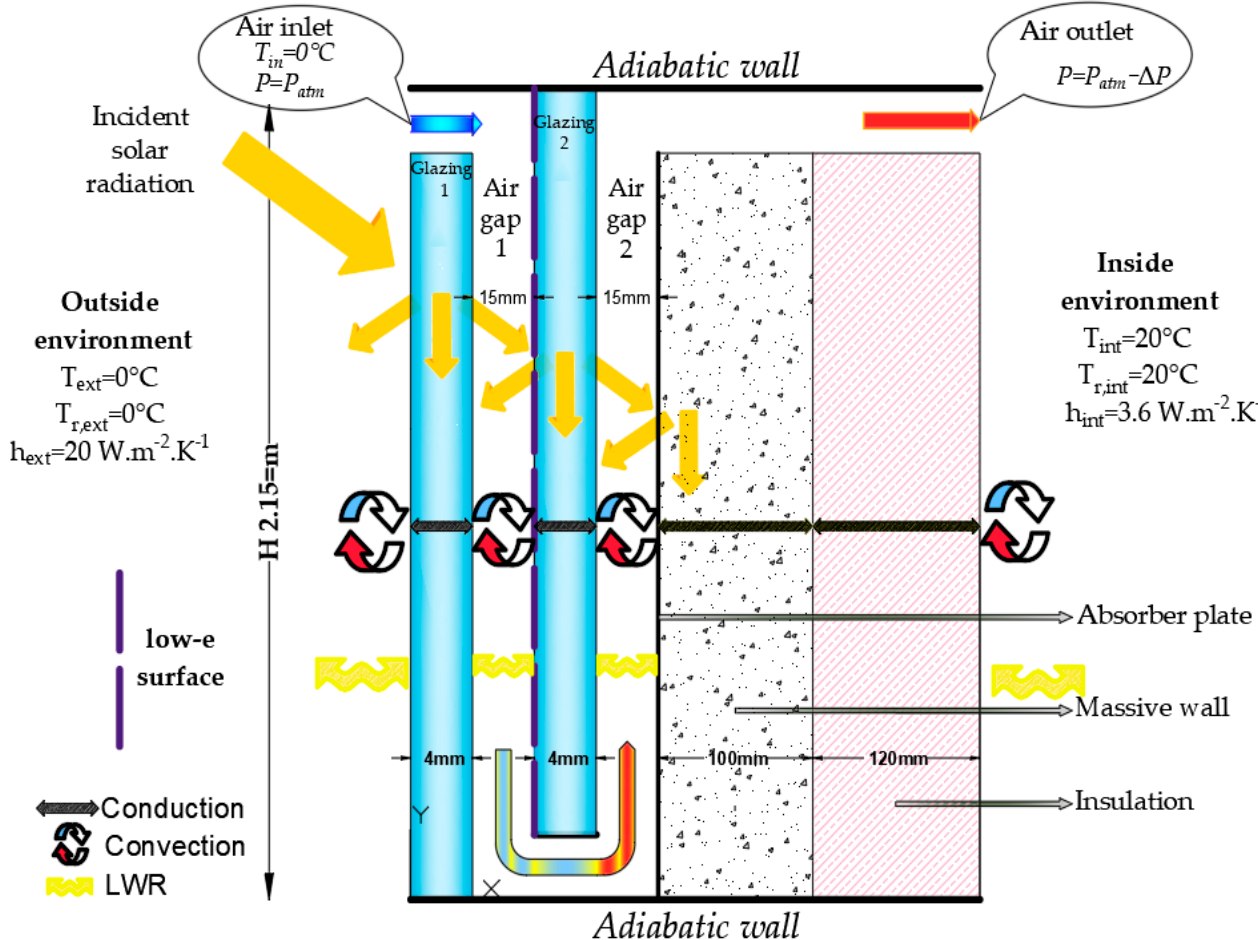
Figure 2. The physical model of the VSW ( not to scale ).